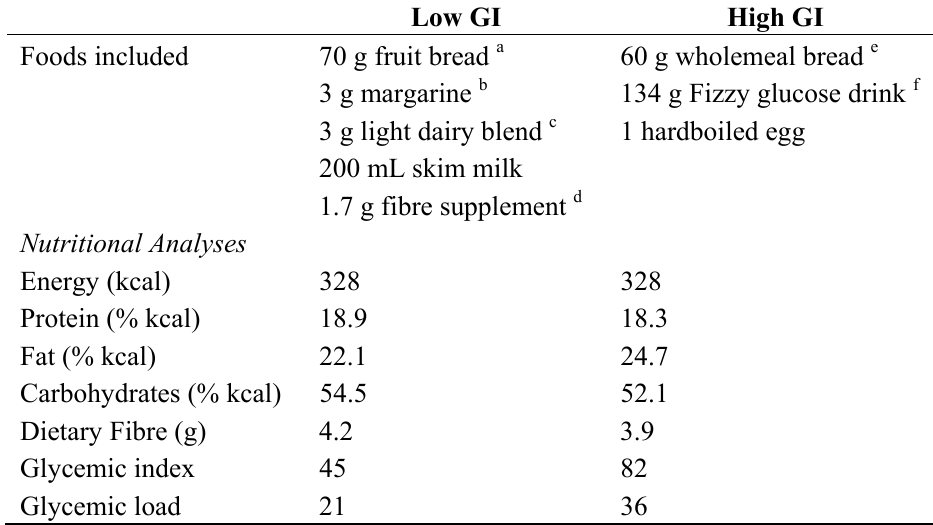
Table 1. Composition and nutritional analysis of the test meals. a Burgen fruit and muesli bread; b Flora mono-sun margarine; c Devondale light dairy blend; d Benefibre fibre supplement; e Tip Top Sunblest wholemeal; f Lucozade orange